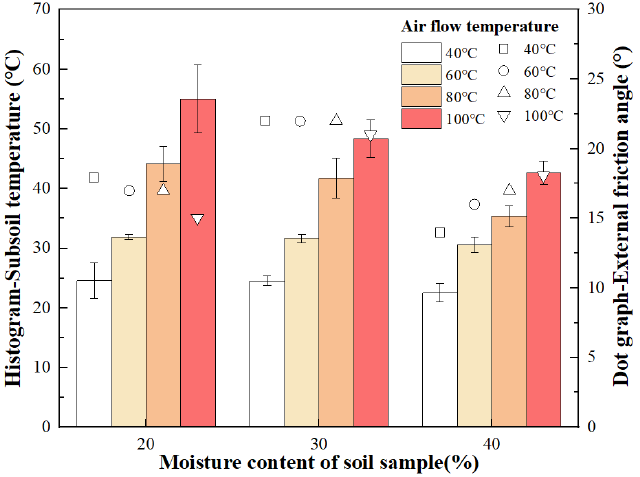
Figure 11. Effect of subsoil temperature on the external friction angle.